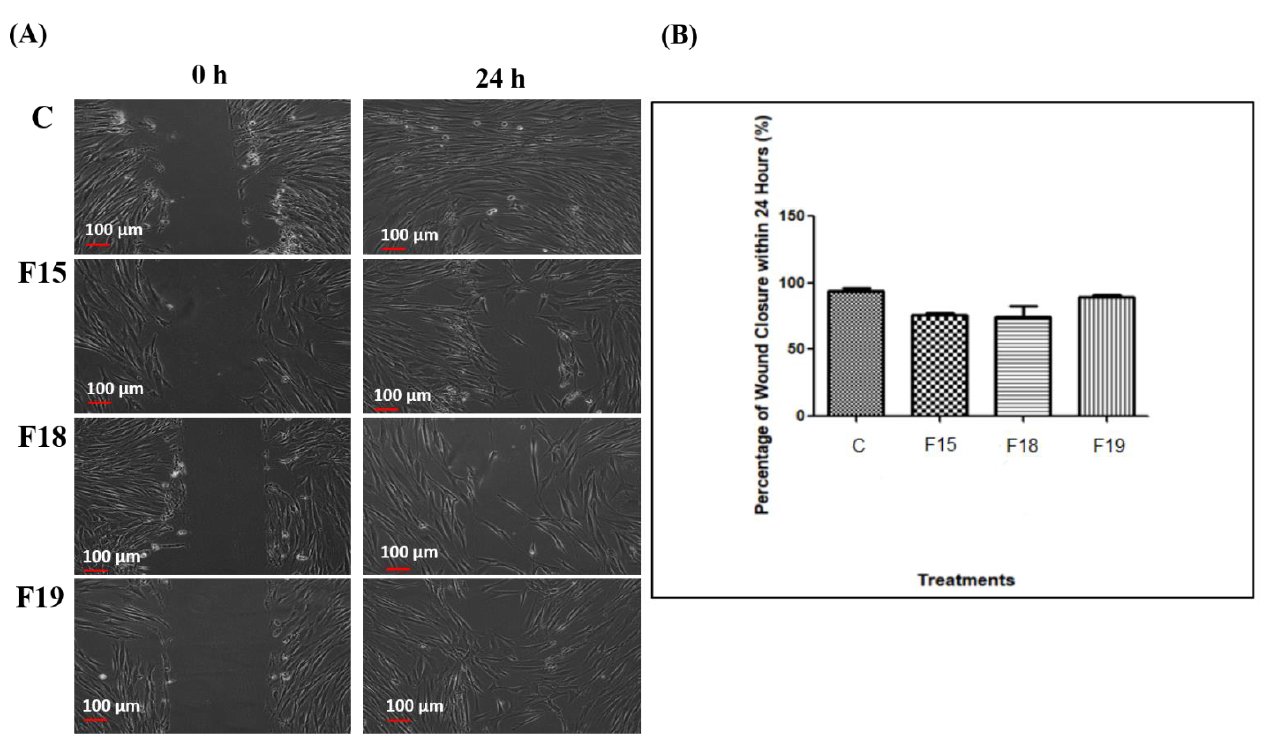
Figure 7. ( A ) Wound scratch assay for HDFs treated with DMEM only as an experimental control ( C ), F15, F18, and F19. ( B ) Percent of wound closure within 24 h for HDFs treated with different treatments.